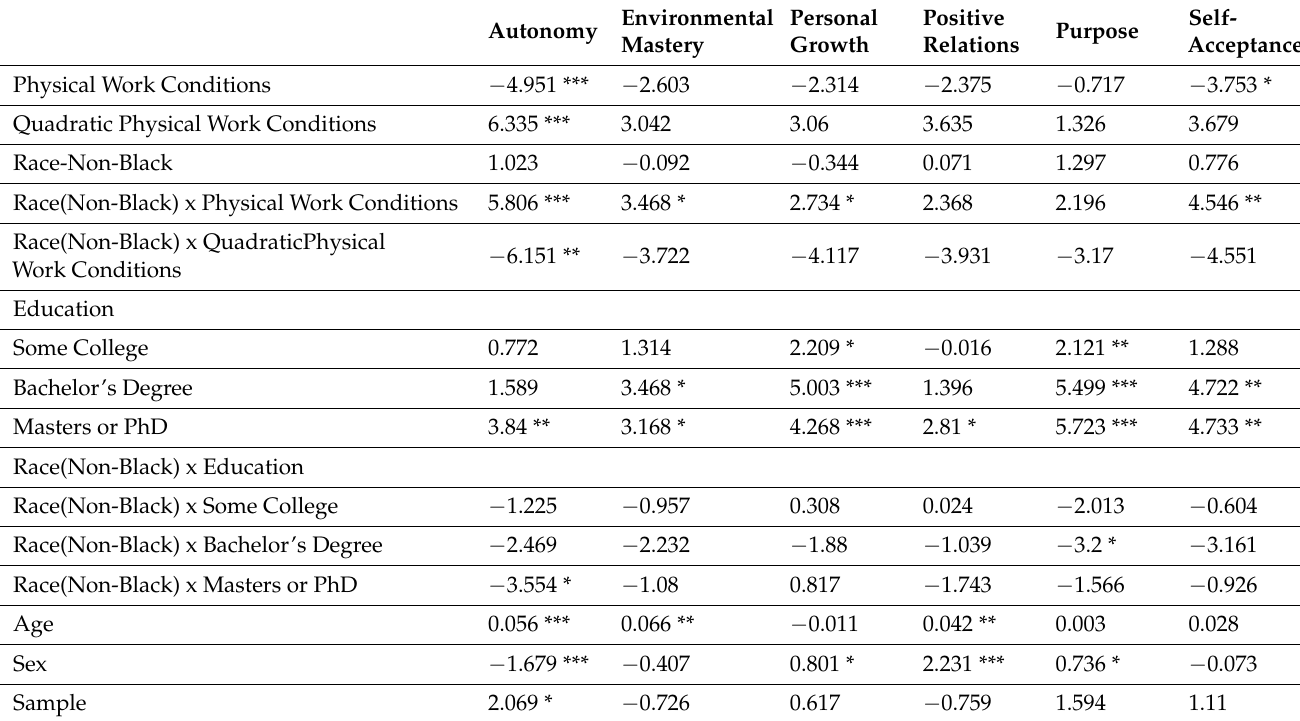
Table A8. Physical Work Conditions and Well-being.